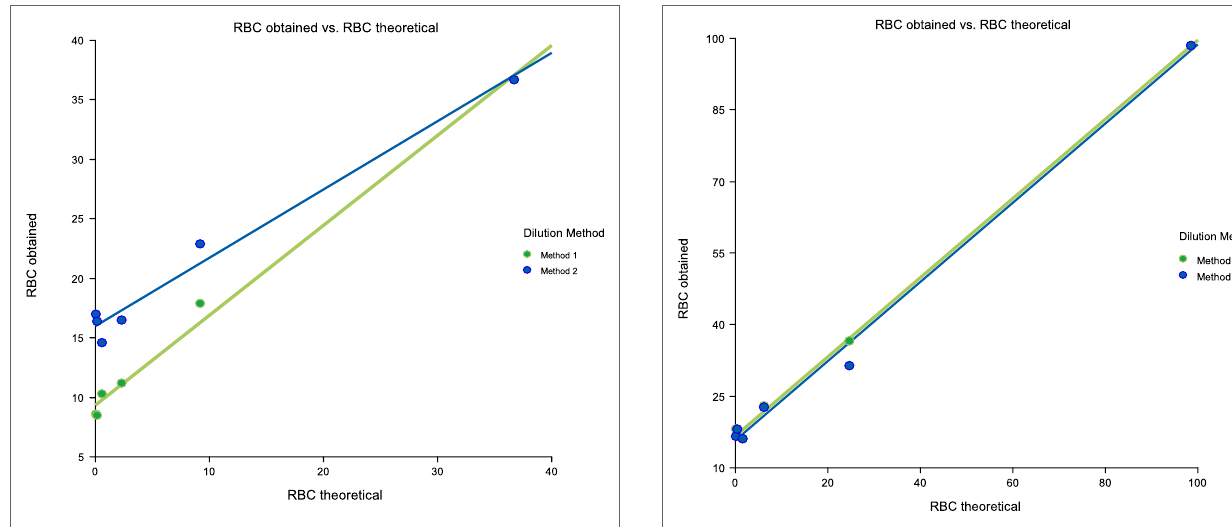
FIgURe 4 | Scatter diagram of obtained and theoretical RBC in sample 1.